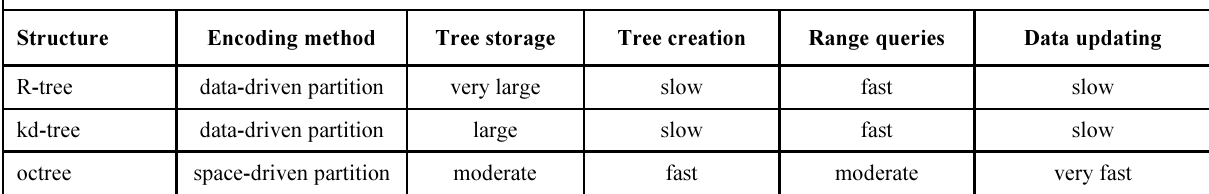
Table 1: Comparison of different tree structure types in respect to their encoding method, the space requirements for the data structure itself, as well as the performance of structure creation, range queries and data updating [Tang,